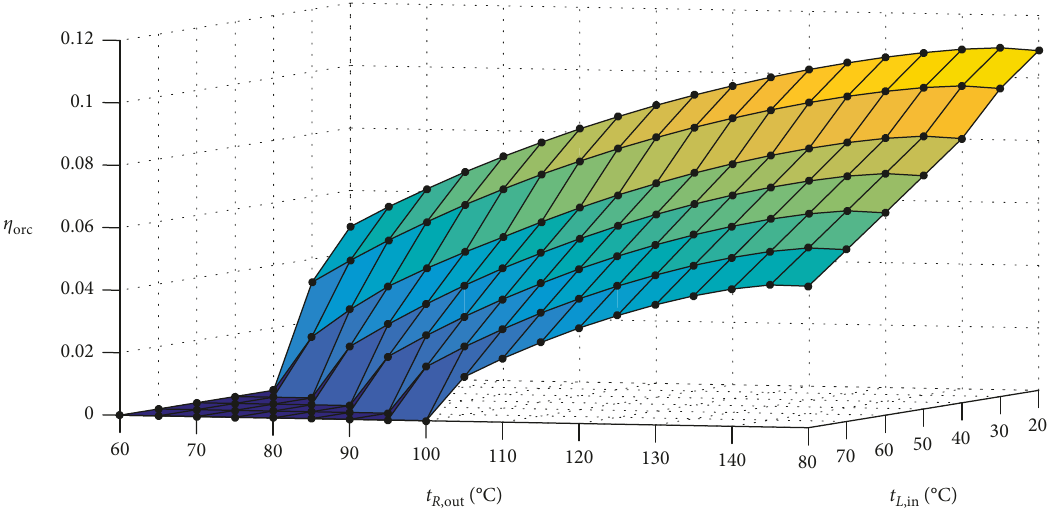
Figure 7: Thermal e ffi ciency of the ORC subsystem ( t